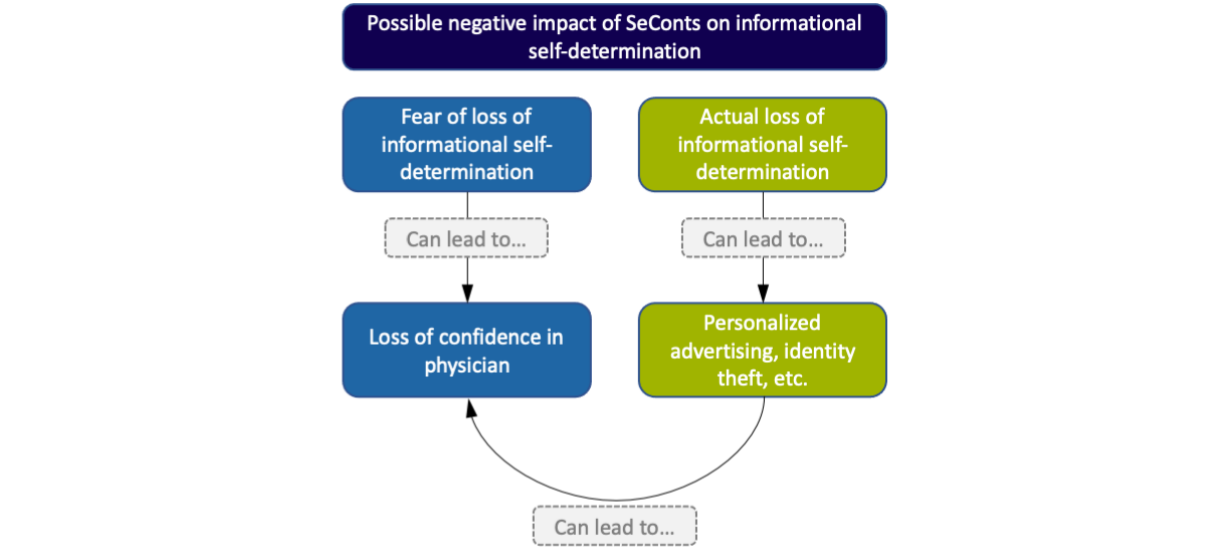
Figure 2. Possible negative impact of the secondary use of clinical data in data-gathering, non-interventional research or learning activities on the patient’s ability to exercise informational